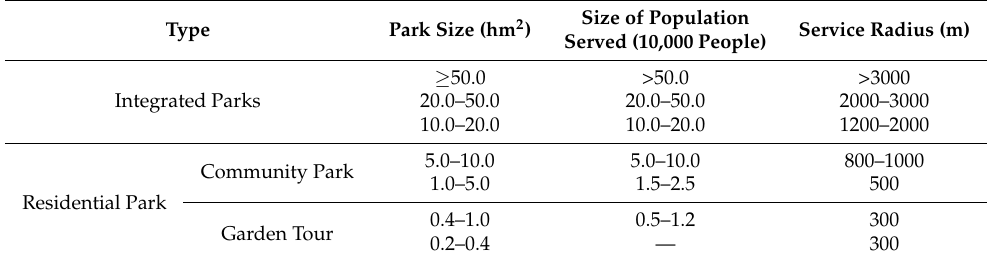
Table 5. The standard service scopes for city parks of different sizes.